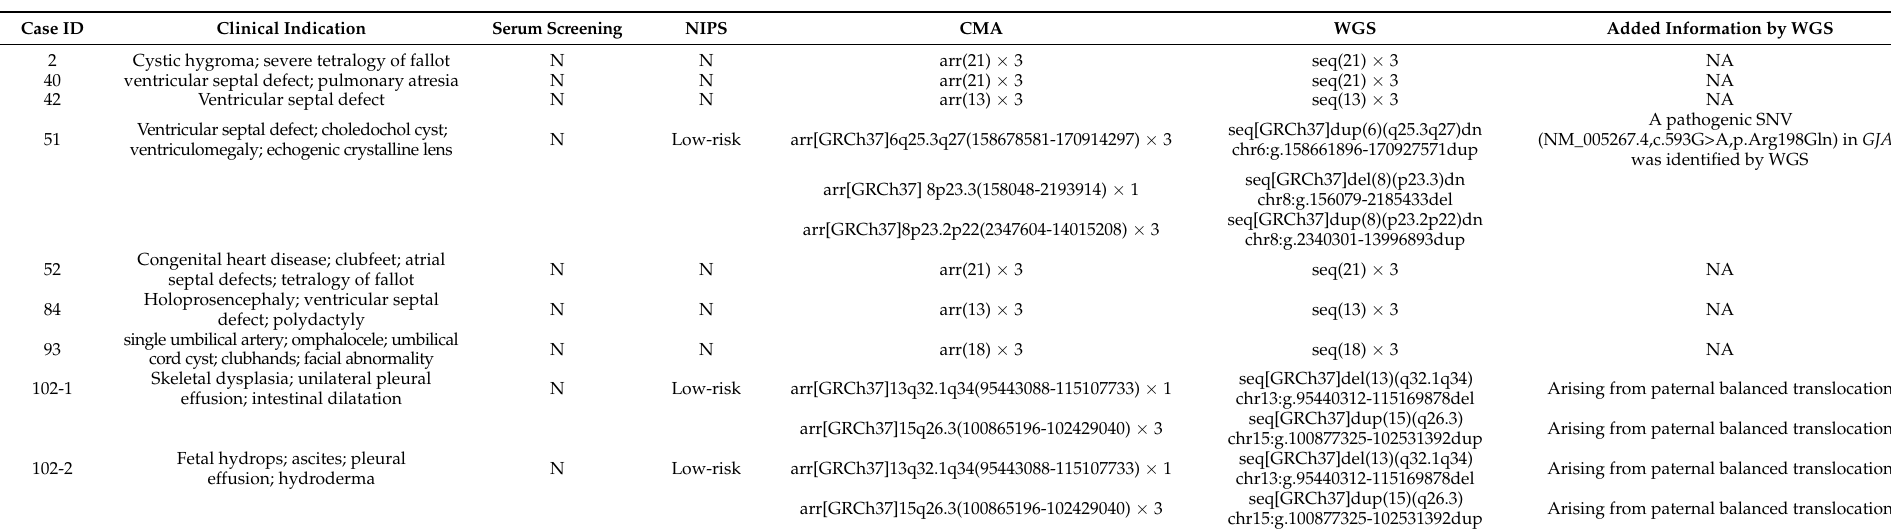
Table 1. Summary of numerical disorder and pathogenic or likely pathogenic copy number variants (CNVs) detected by CMA and WGS.